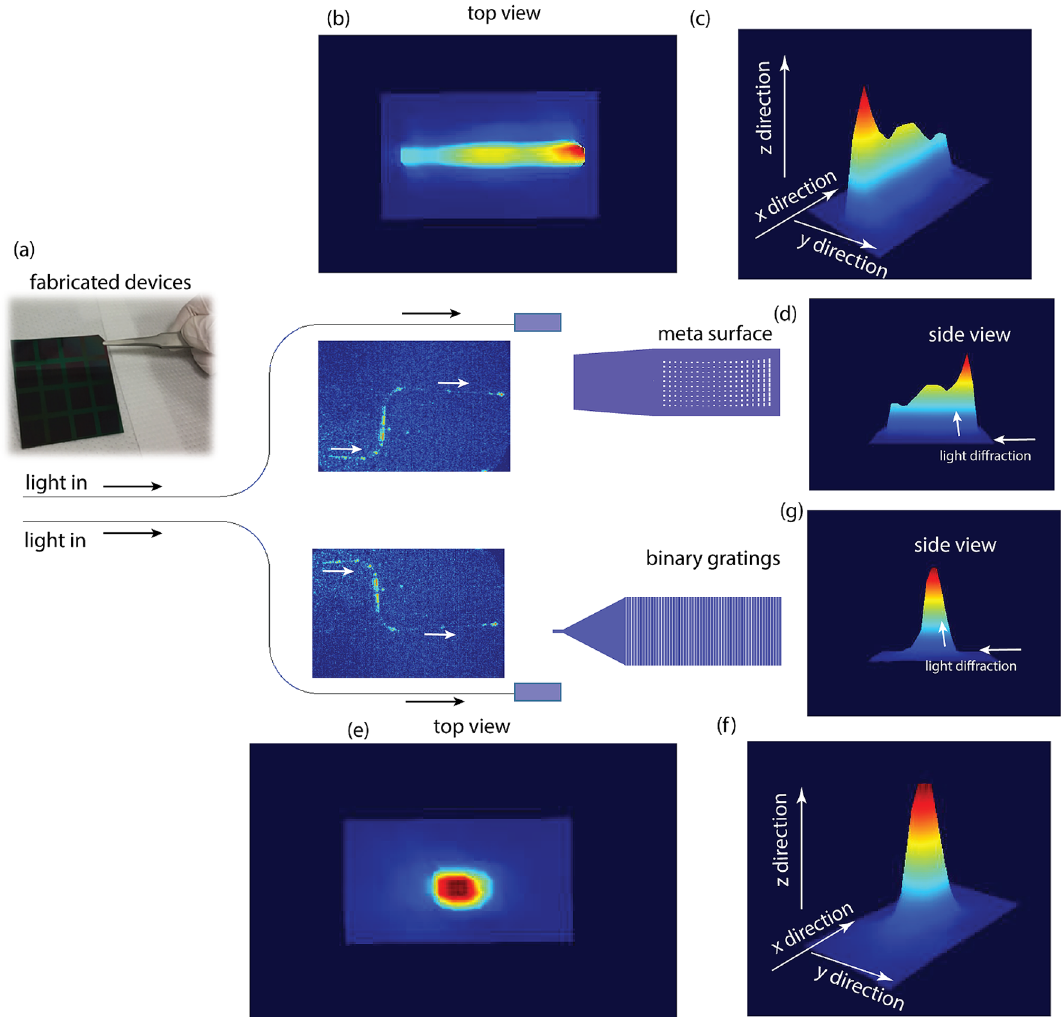
Figure 7. Experimental comparison of metasurface and conventional binary grating-based diffractor. ( a ) The fabricated sample. ( b , e ) Microscopic top view of the light diffraction from the photonic meta surface and binary gratings. ( c , d , f , g ) 3D and side view of the beam profiles from the metasurface and the binary grating structure. Figure created in CinCam beam